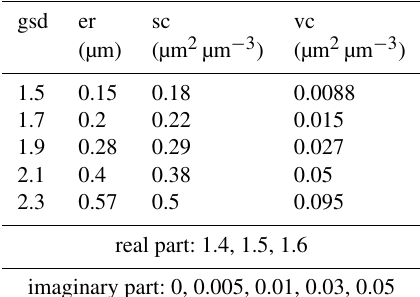
Table 1. Input parameters of the particle size distributions used in the simulation studies. We used monomodal PSDs with mean radius 100nm. We used PSDs normalized to one particle per cm 3 , gsd ( σ ) denotes the geometric standard deviation (mode width), er is the effective radius, sc is the surface area concentration, and vc the volume